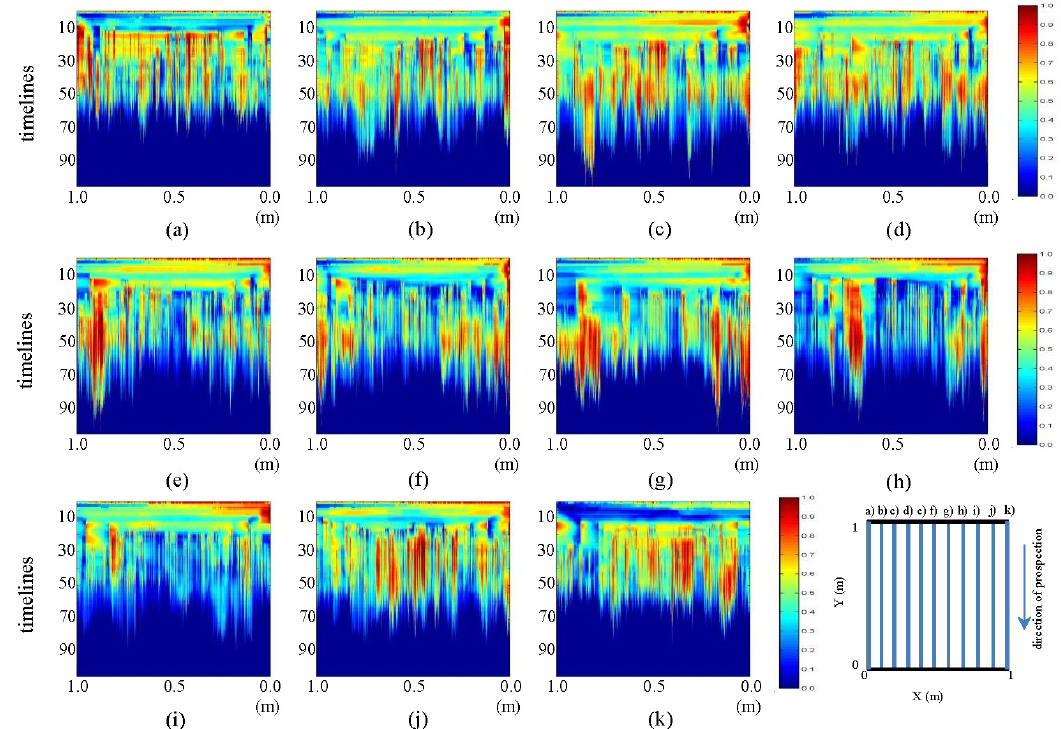
Figure 14. Vertical profiles: pre-processed images for the initial state. ( a – k ) are profiles s12 to s22,